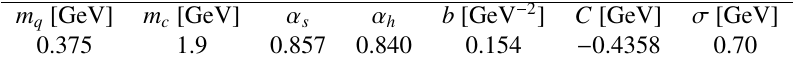
Table 2. The meson masses m and Gaussian parameter b G obtained in the single Gaussian